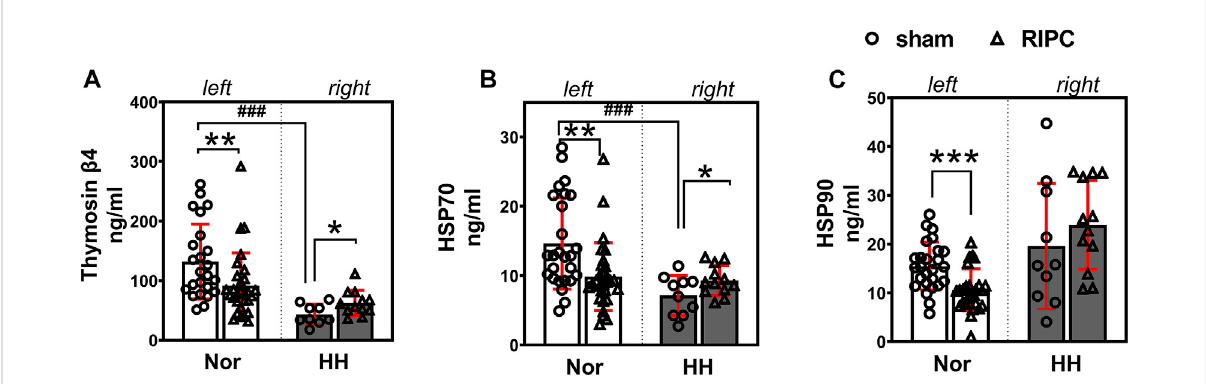
FIGURE 7 EffectofRIPConT β 4,HSP70,andHSP90. (A) T β 4, (B) HSP70,and (C) HSP90levelsinparticipants ’